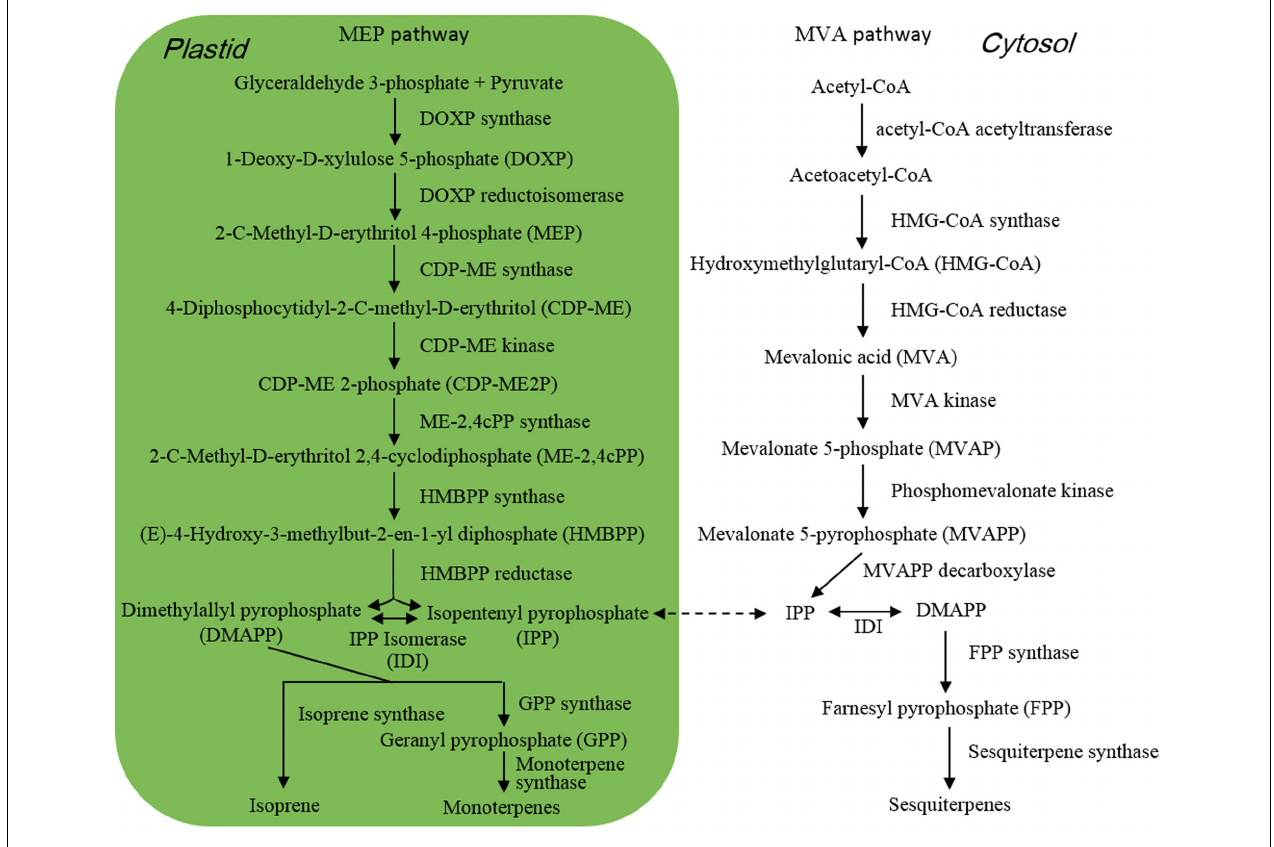
FIGURE 2 | Pathway of terpene